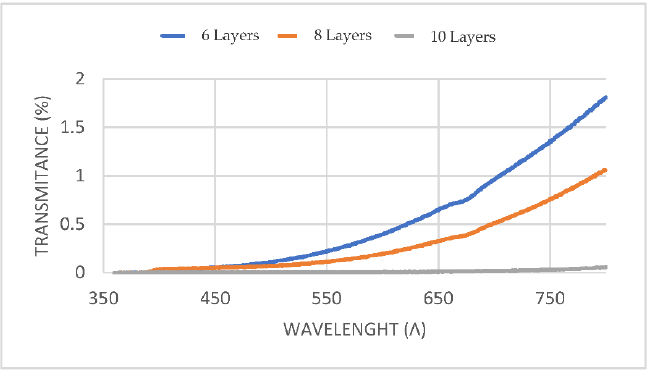
Figure 10. Transmittance by wavelength of the samples under study.